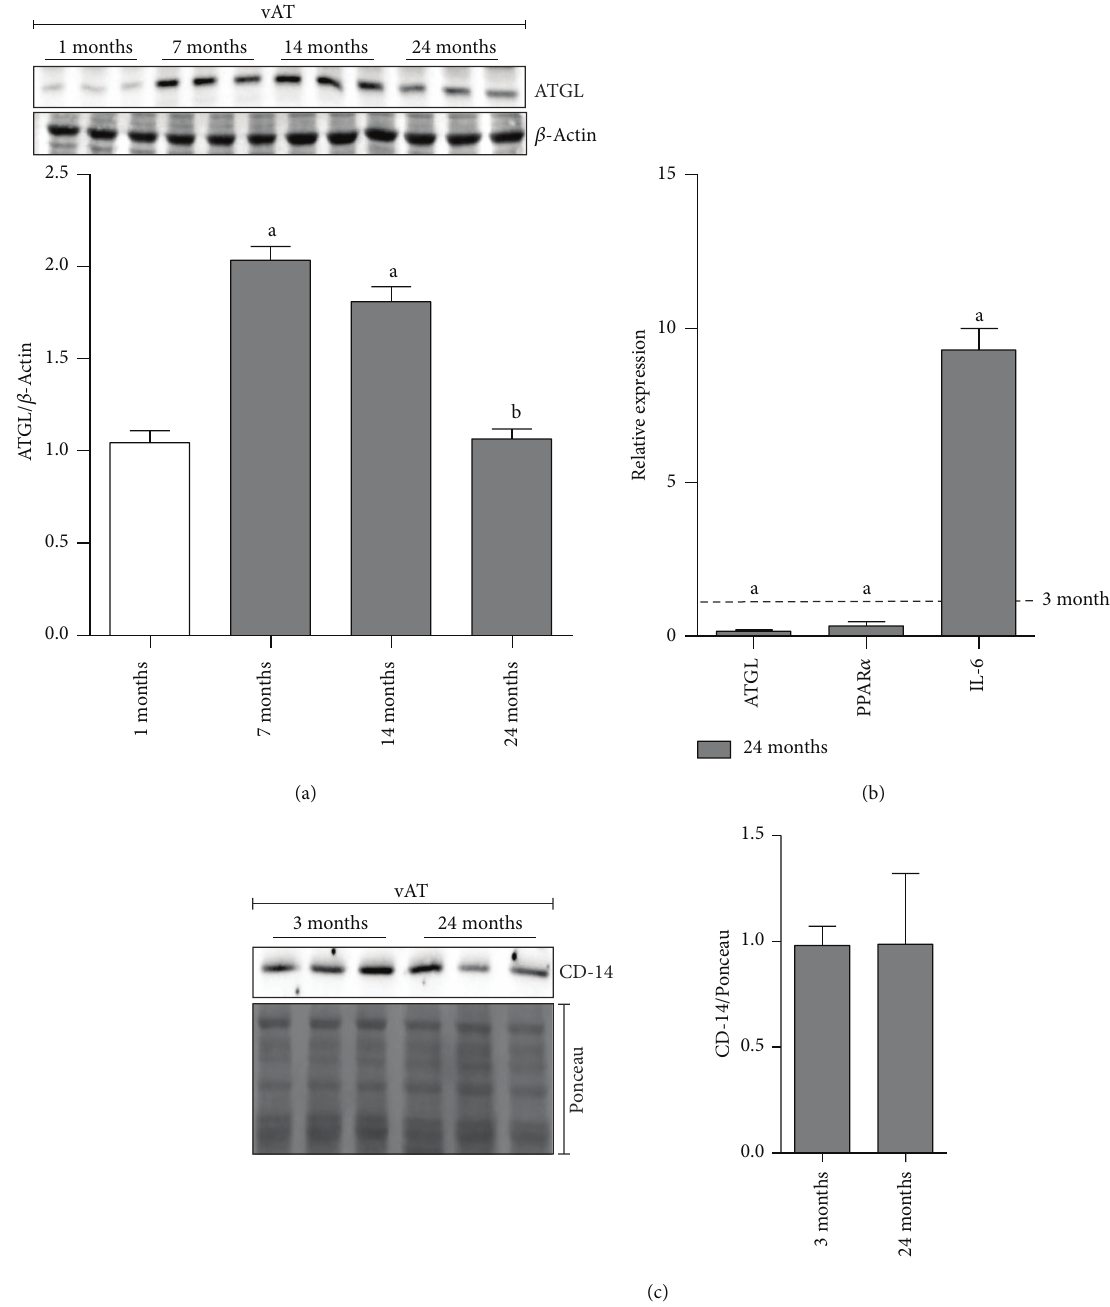
Figure 1: Failure of ATGL/PPAR 𝛼 upregulation is associated with increased IL-6 in vAT of 24-month-old mice. (a) Upper panel : western blotting analysis of ATGL in total protein extracts from mice vAT at different age ( 𝑛 = 3 mice/group). Lower panel : the content of ATGL protein was quantified by densitometric analysis. Data are expressed as ATGL/ 𝛽 -actin. Values are given as means ± S.D. ( a ) 𝑃 < 0.05 versus 1-month-old mice; ( b ) 𝑃 < 0.05 versus 7- and 14-month-old mice. (b) RT-qPCR analysis of relative ATGL, PPAR 𝛼 , and IL-6 mRNA levels in vAT of 3-month- and 24-month-old mice ( 𝑛 = 3 mice/group). Values are given as means ± S.D. ( a ) 𝑃 < 0.05 versus 3-month-old mice. (c) Upper panel : western blotting analysis of CD-14 in total protein extracts from vAT of 3-month- and 24-month-old mice ( 𝑛 = 3 mice/group). Lower panel : the content of CD-14 protein was quantified by densitometric analysis. Data are expressed as CD-14/Ponceau. 𝛽 -Actin and Ponceau-stained membranes were used as loading